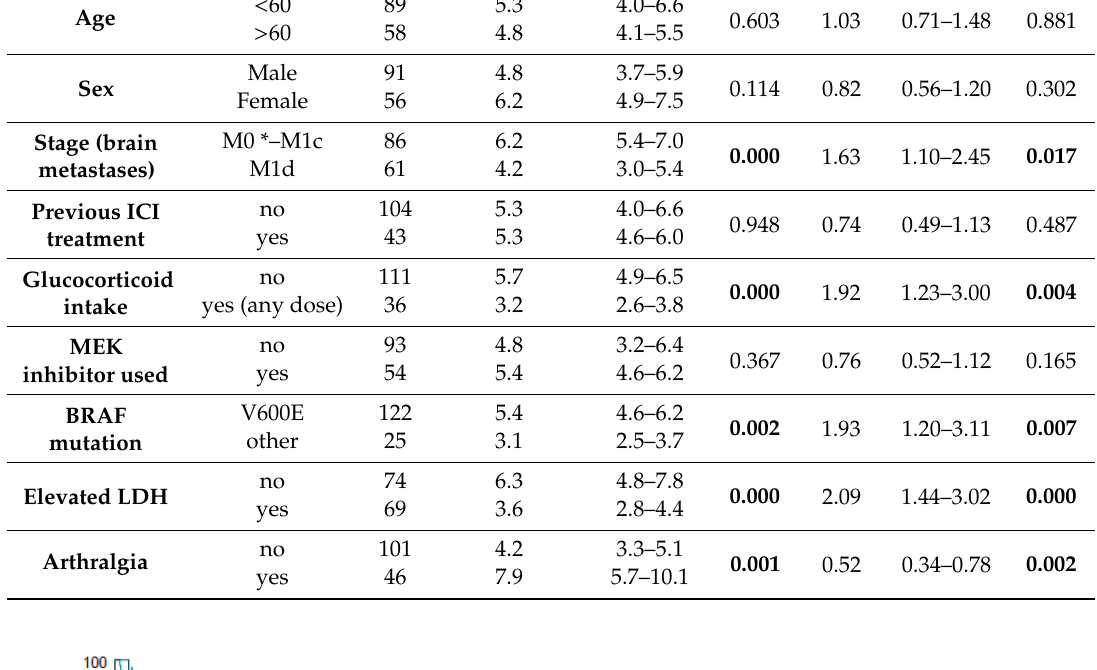
Table 4. Influence of age, sex, tumor stage, previous immune checkpoint inhibitor (ICI) treatment, glucocorticoid intake, use of MEKi, BRAF mutation, elevated lactate dehydrogenase (LDH), and arthralgia on progression-free survival (PFS). PFS was available for 147 patients. Multivariate analysis was performed by Cox regression. Bold print indicates significant p values. * Two patients had advanced locoregional disease without distant metastases.